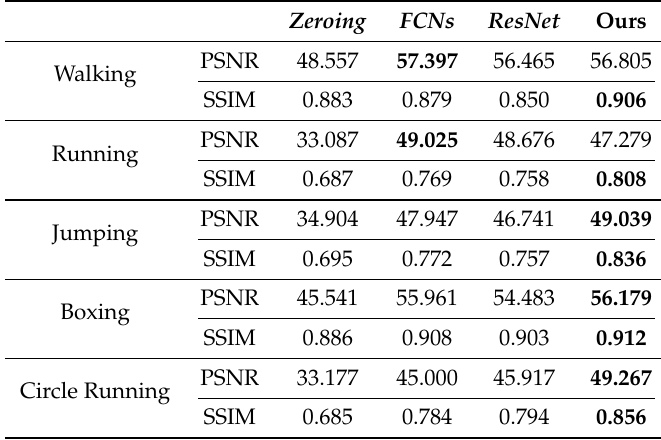
Table 3. Performance on the Measured Radar Spectrograms of Five Human Activities.